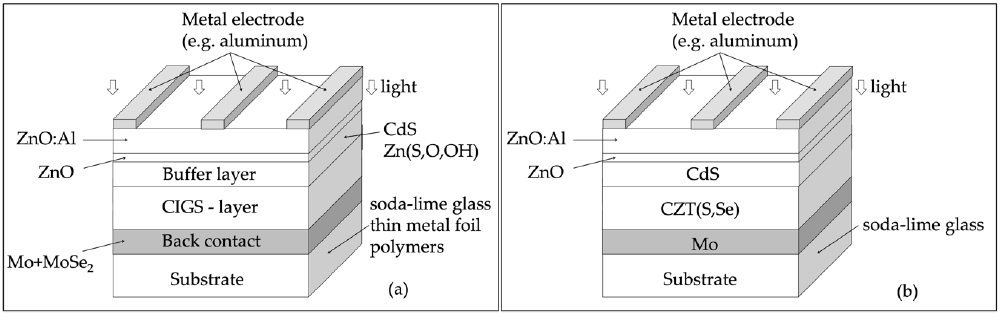
Figure 4. ( a ) CIGS solar cell which evidenced the possibility of using different types of substrates. ( b ) CZTSSe solar cell; the stacked layers are almost the same, except for the absorber.